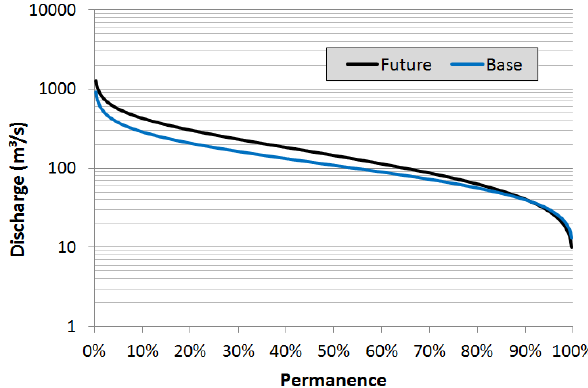
Figure 7. Mean value of permanence curves of monthly flow ac- cording to the stochastic series generated during the base (1961– 1990) and future periods (2011–2040), at Santo Ângelo gauge sta- tion.